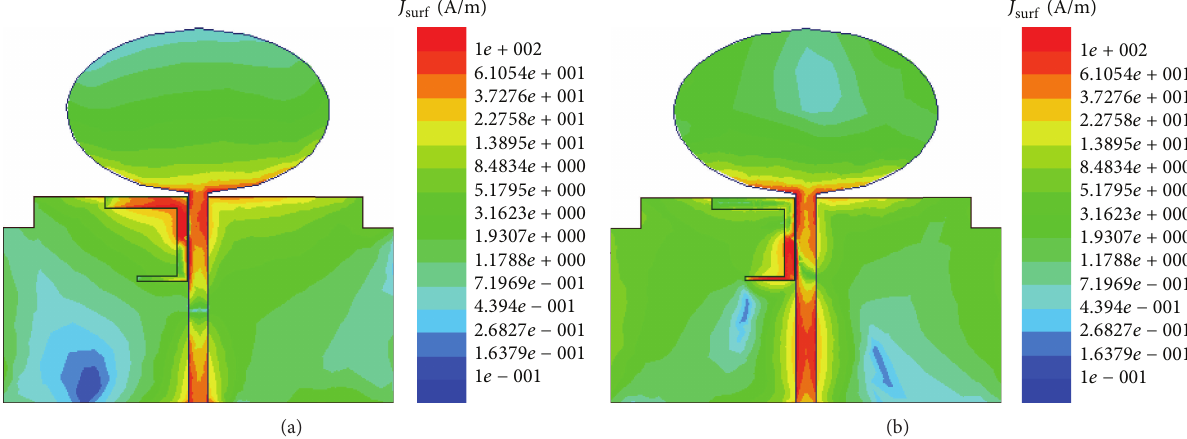
Figure 9: Surface current distribution at (a) 3.6 GHz and (b) 5.5